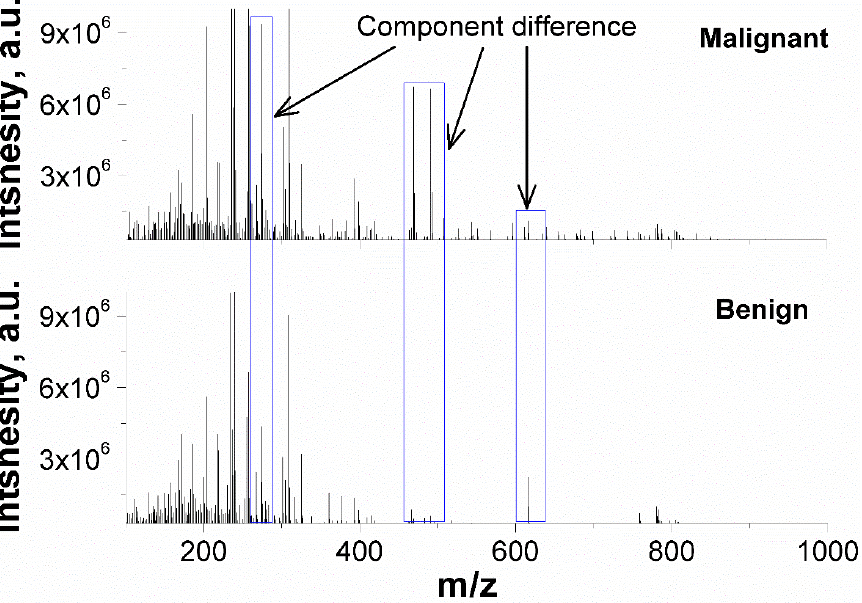
Figure 2. Representative PESI-MS spectra of malignant and benign nodules in positive mass mode.